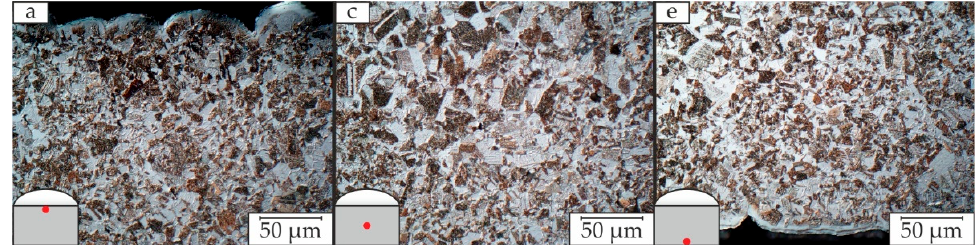
Figure A1. Position and quantity of the hardness measurements carried out.